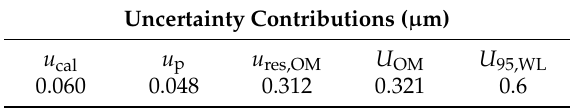
Table 2. The uncertainty contributions for the thickness of the white layer measurements on microscope.